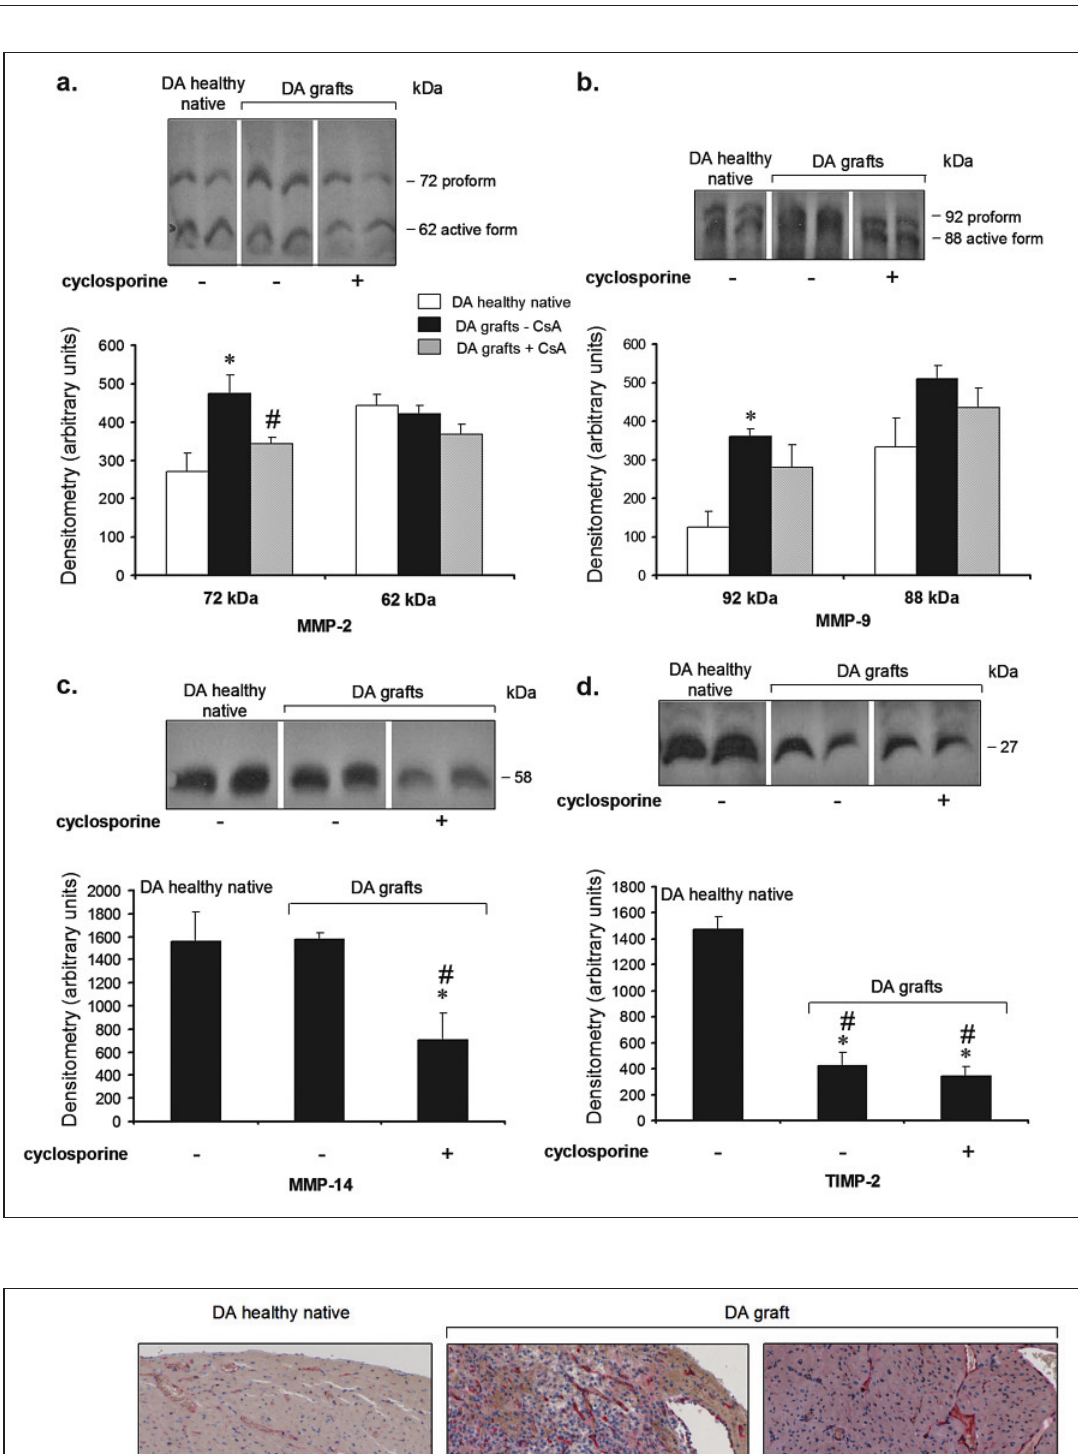
MMP-2 immunohis- tology in Dark Agouti (DA) heart sections. The increased pres- ence of MMP-2 was observed in the my- ocardium of acutely rejected DA hearts (middle panel), as compared to the healthy control (left panel). CsA reduced acute rejection and consequently also the MMP-2 signal (right